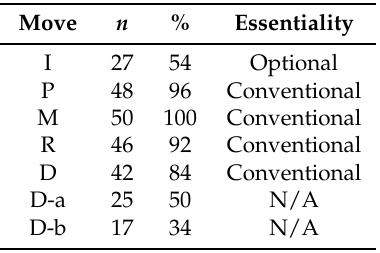
Table 4. Number and percentage of abstracts with five moves in the present study ( n =